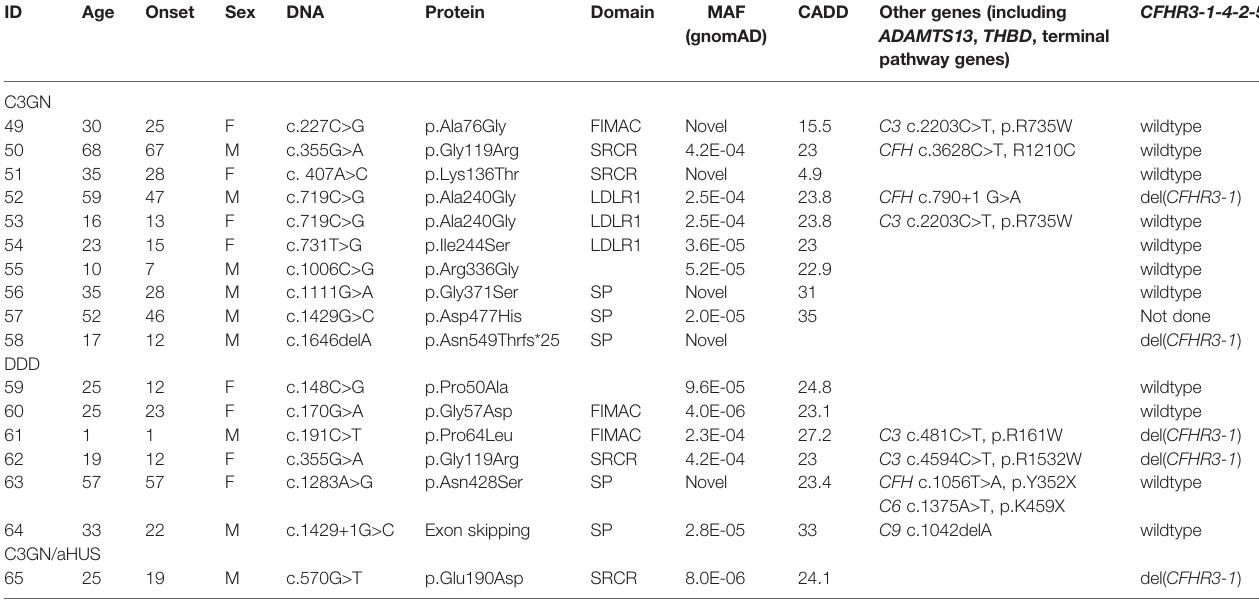
TABLE 3 | Demographic and genetic data in patients with